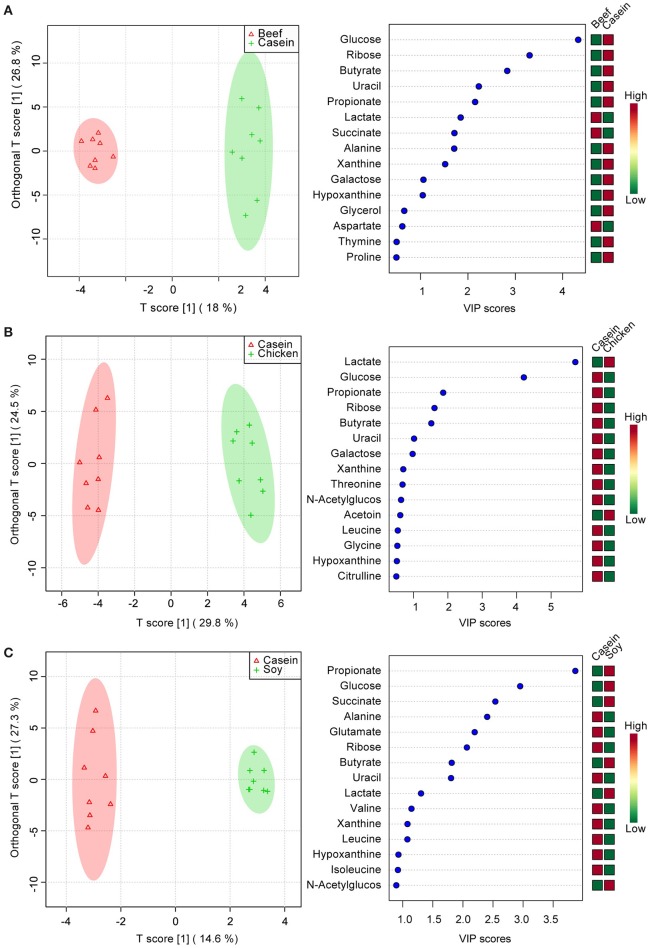
Pairwise comparisons between colonic contents extract spectra obtained from the beef, chicken and soy protein groups using OPLS analysis. Each figure has two parts: the left part is OPLS score plot, the right part is top 15 VIP scores. (A) beef protein group vs. casein group; (B) soy protein group vs. casein group; (C) chicken protein group vs. casein group.